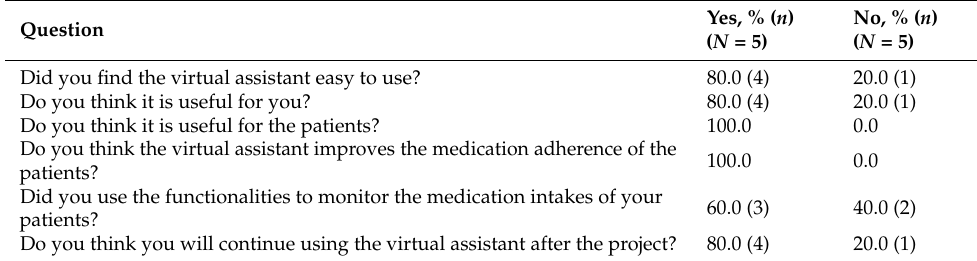
Table 8. Healthcare professionals’